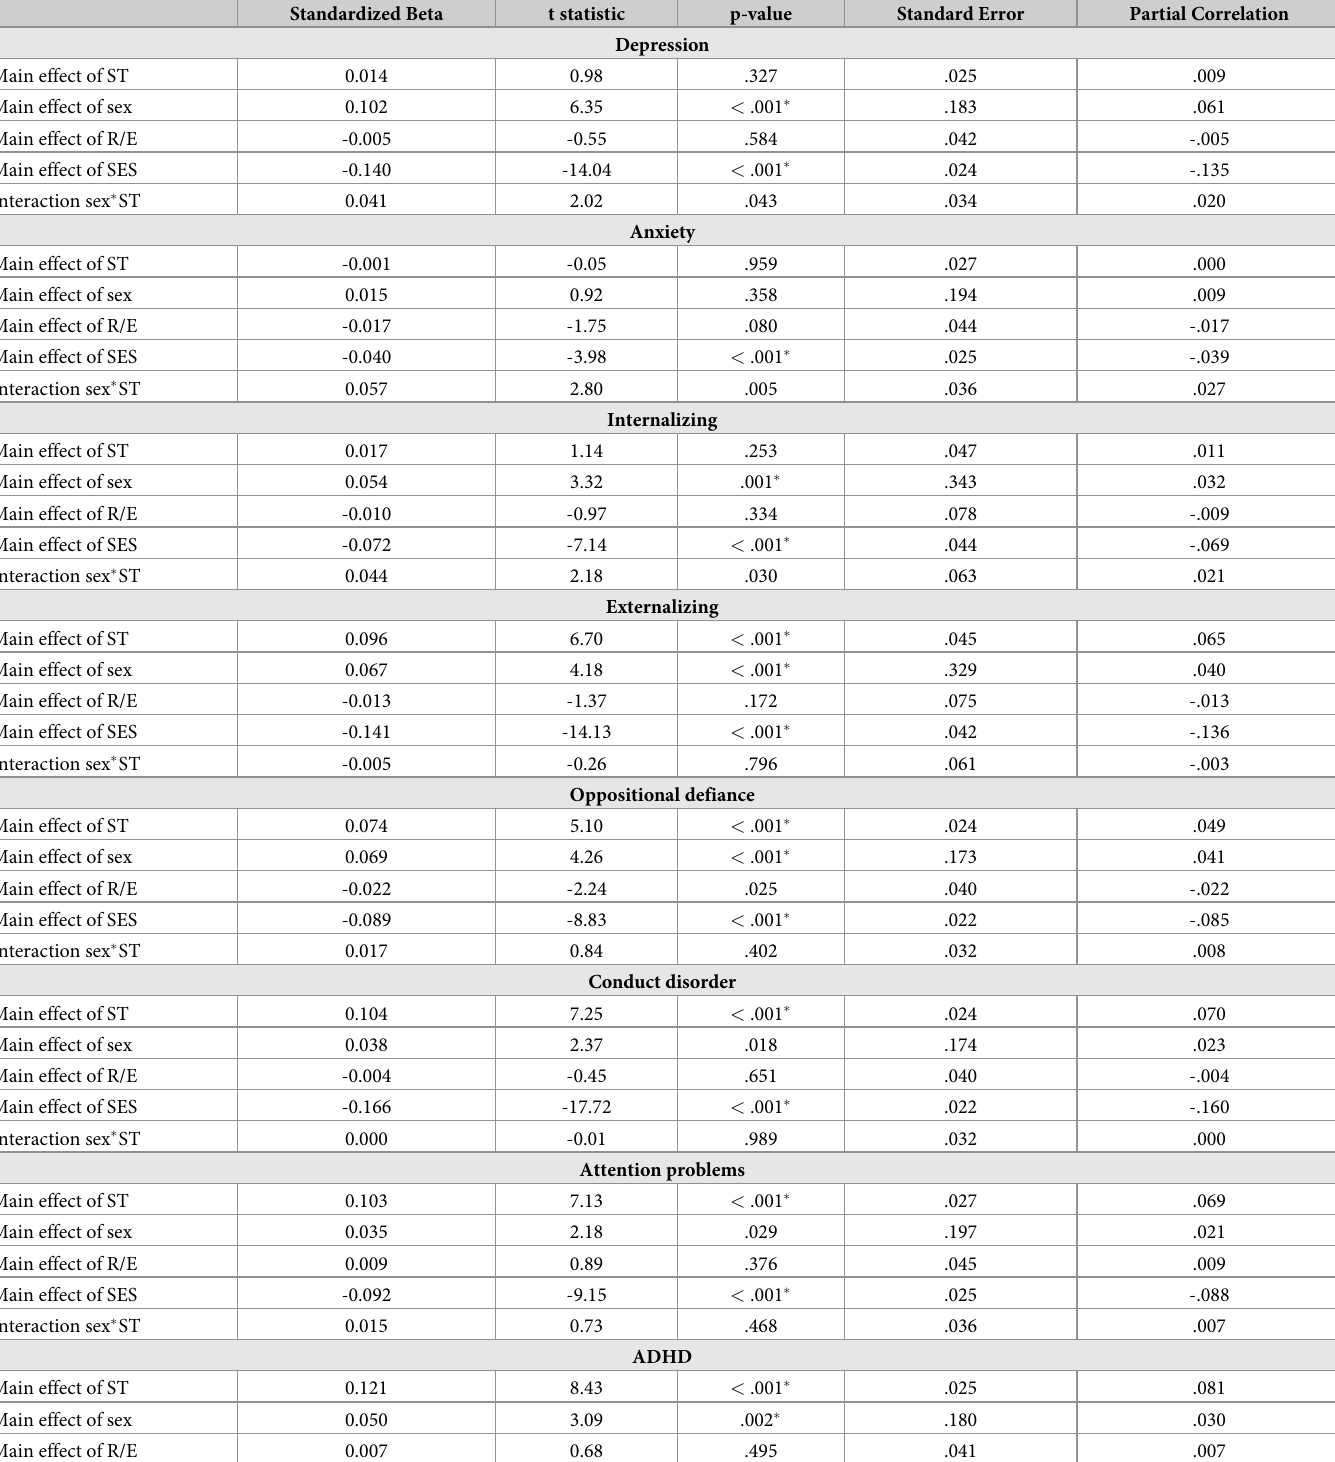
Table 4. Examination of main effects of weekend screen time and sex, as well as the interaction between them, on outcome variables, controlling for SES and race/